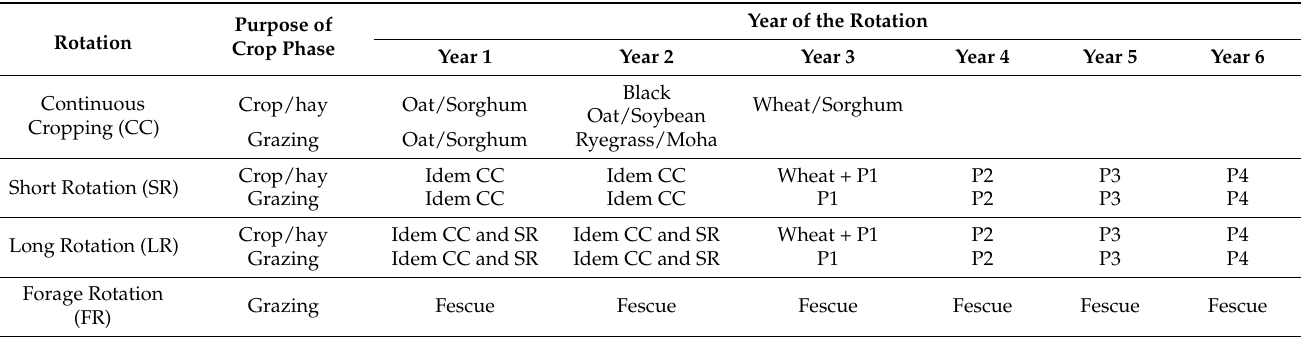
Table 1. Cropping and pasture sequences of the 4 pasture–crop rotations in the ‘Palo a Pique’ long-term